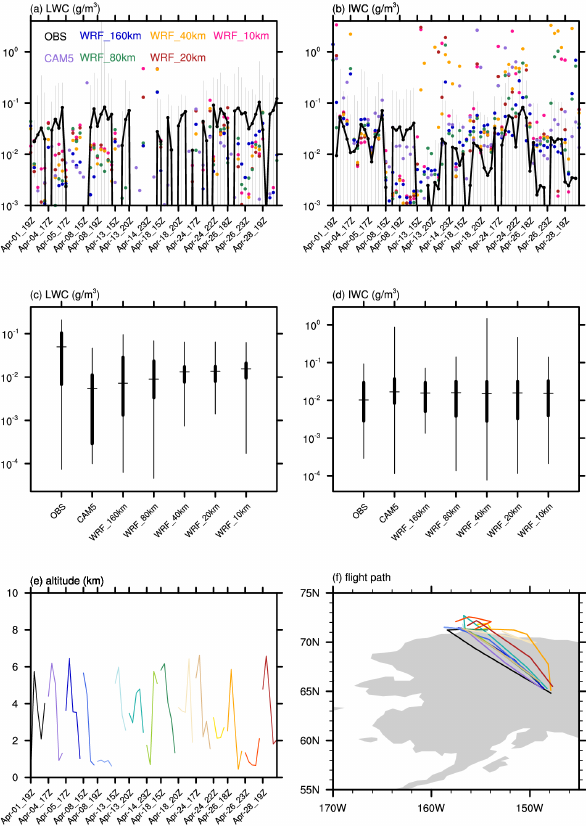
Fig. 3. The simulated and observed (a) wind speed (ms − 1 ) , (b) wind direction (degree), (c) temperature (K), and (d) water va- por mixing ratio (gkg − 1 ) at (e) altitude along (f) the DC-8 flight path on 16 April 2008, during the ARCTAS field campaign. The blue star in (f) denotes the location of Barrow, Alaska (71.32 ◦ N, 156.62 ◦ W).